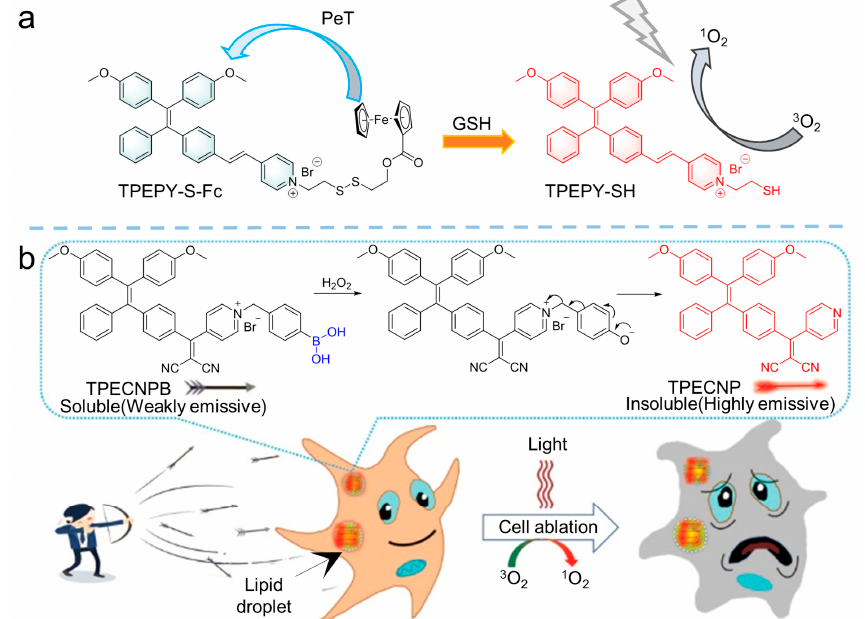
Figure 8. Activatable photosensitizer strategy to manipulate ROS generation by GSH and H 2 O 2 . ( a ) Molecular structure of TPEPY-S-Fc and the proposed mechanism of GSH-activated PDT. Reprinted with the permission of the authors of [57]. Copyright 2020, Royal Society of Chemistry. ( b ) Molecu- lar structure of TPECNPB and the schematic illustration of H 2 O 2 activation of PDT. Reprinted with the permission of the authors of [61]. Copyright 2020, Wiley-VCH GmbH.